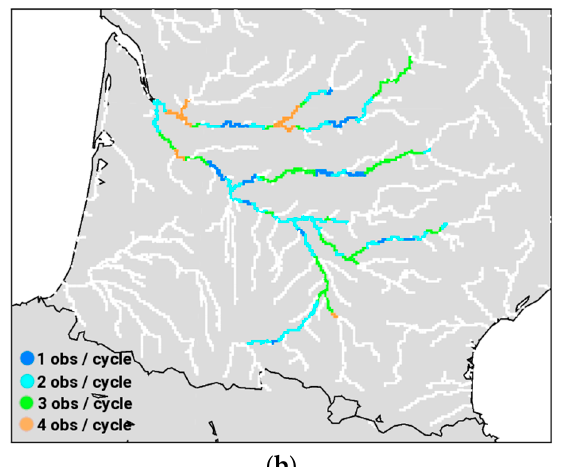
Figure 5. ( a ) River widths computed in the DA platform over the Garonne catchment, considering three river width classes where virtual SWOT observations are assimilated; ( b ) SWOT observation number for a 21-day cycle for every 10-km reaches of the Garonne catchment.